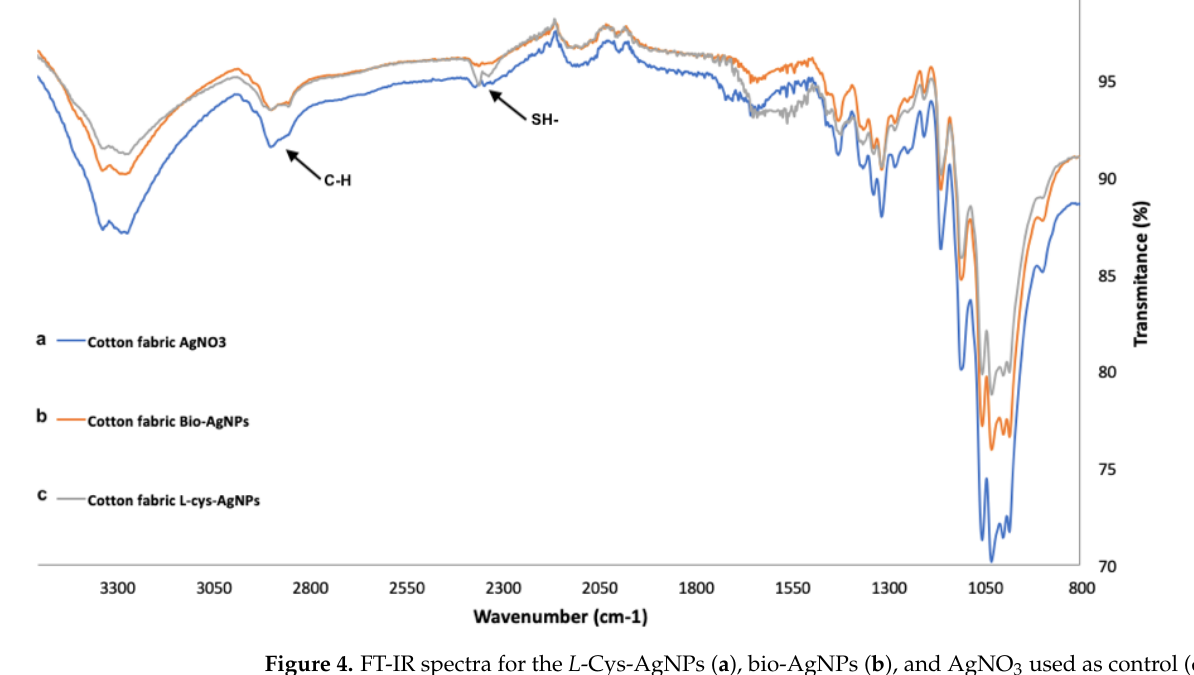
Figure 4. FT-IR spectra for the L -Cys-AgNPs ( a ), bio-AgNPs ( b ), and AgNO 3 used as control ( c